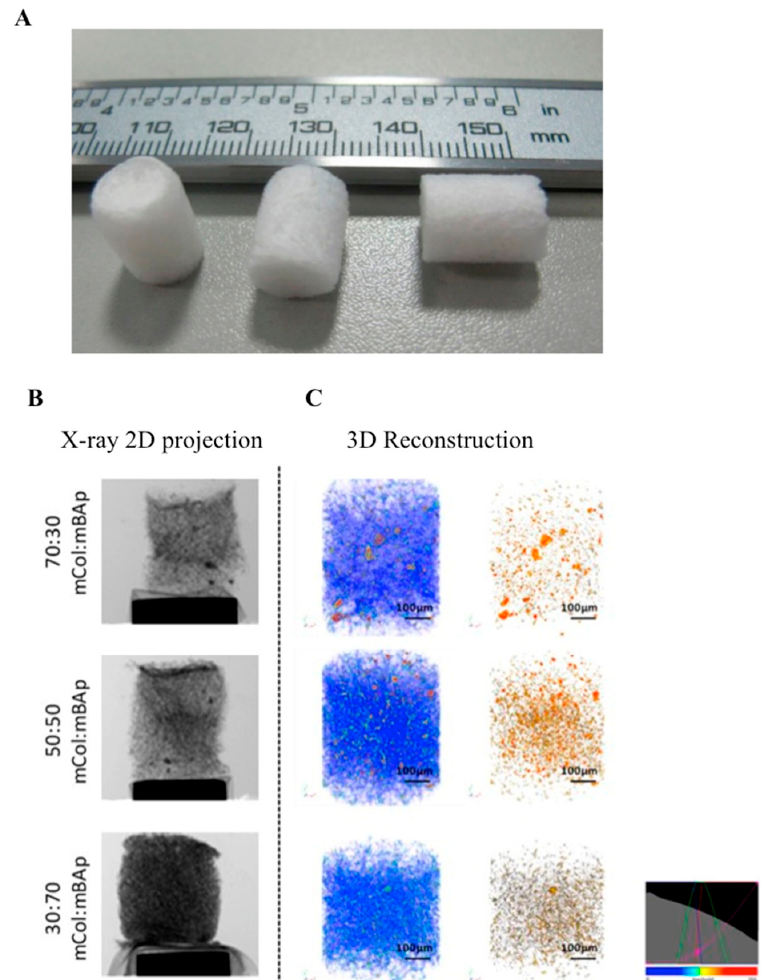
Figure 3. ( A ) Sca ff olds of marine collagen: marine biopatite particles composite. Representative images Figure 3. ( A ) Scaffolds of marine collagen: marine biopatite particles composite. Representative of 12.5% 1-[3-(dimethylamino)propyl]-3-ethylcarbodiimide hydrochloride / N-Hydroxysuccinimide images of 12.5% 1-[3-(dimethylamino)propyl]-3-ethylcarbodiimide hydrochloride/N- (EDC / NHS) crosslinked sca ff olds obtained by microcomputed tomography (micro-CT). ( B ) X-ray 2D Hydroxysuccinimide (EDC/NHS) crosslinked scaffolds obtained by microcomputed tomography (micro-CT). ( A ) X-ray 2D projection and respective ( B ) 3D reconstruction of acquired structures, in projection and respective ( C ) 3D reconstruction of acquired structures, in which the first column which the first column shows a reconstruction of both polymeric and ceramic phases, and the second shows a reconstruction of both polymeric and ceramic phases, and the second column shows only column shows only the ceramic phase. Homogeneous distribution of the materials is observed, the ceramic phase. Homogeneous distribution of the materials is observed, according to a color scale: according to a color scale: blue = soft material (marine collagen); brown = hard material (marine blue = soft material (marine collagen); brown = hard material (marine biopatite particles). Adapted biopatite particles). Adapted from a previous study [105] with permission. from a previous study [105] with